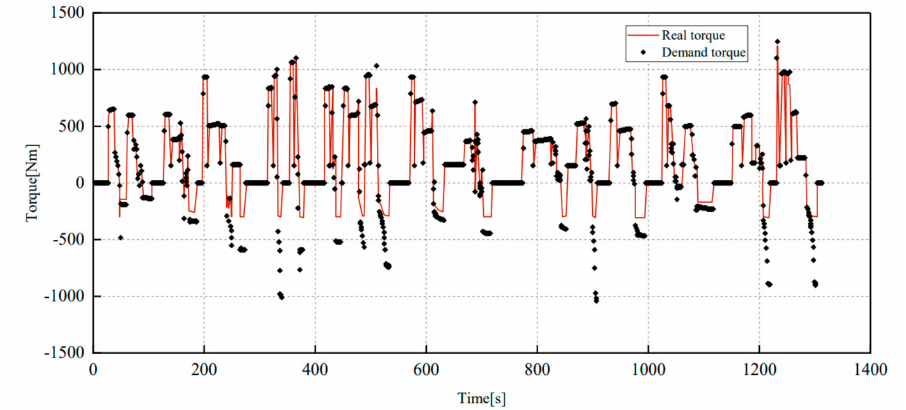
Figure 10. Comparison of demand torque and real torque.